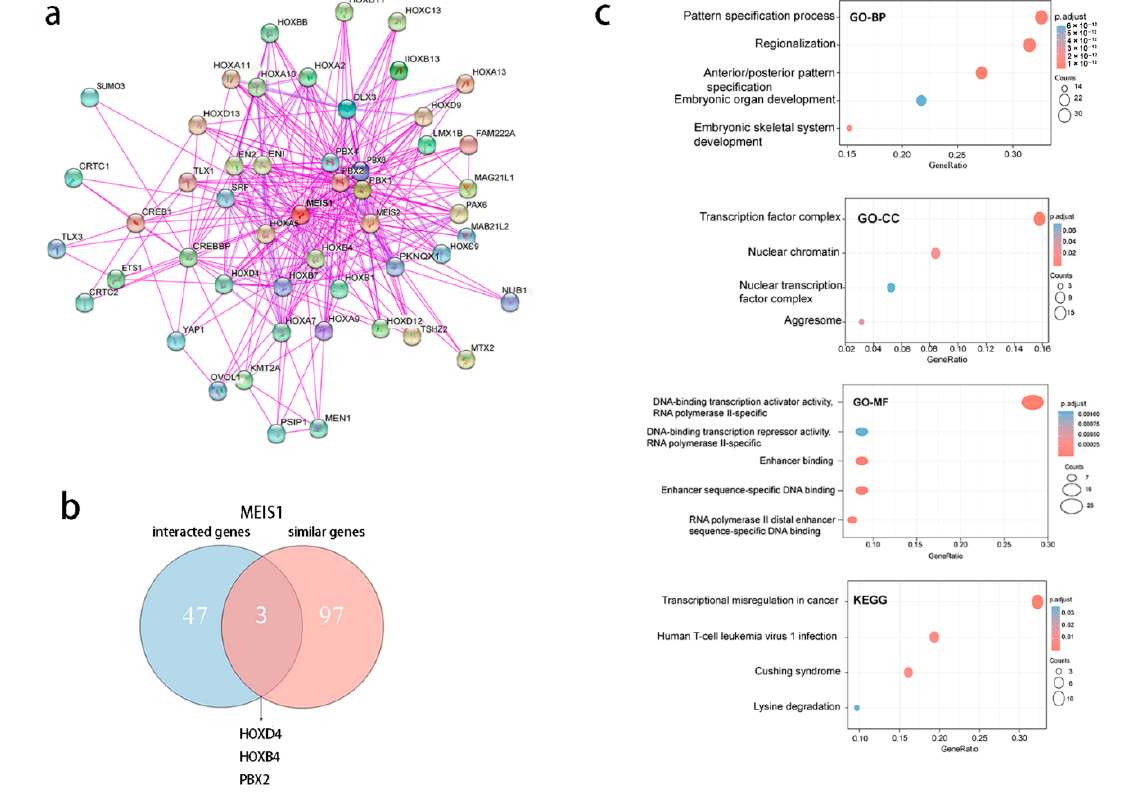
Figure 9. MEIS1-related genes’ enrichment analysis. ( a ) 50 MEIS1-binding proteins’ interaction net- work derived from STRING. ( b ) Venn diagram showing the intersection between MEIS1-interacted genes and MEISI-correlated genes. ( c ) Bubble diagram for GO and KEGG analysis of MEIS1-related genes.